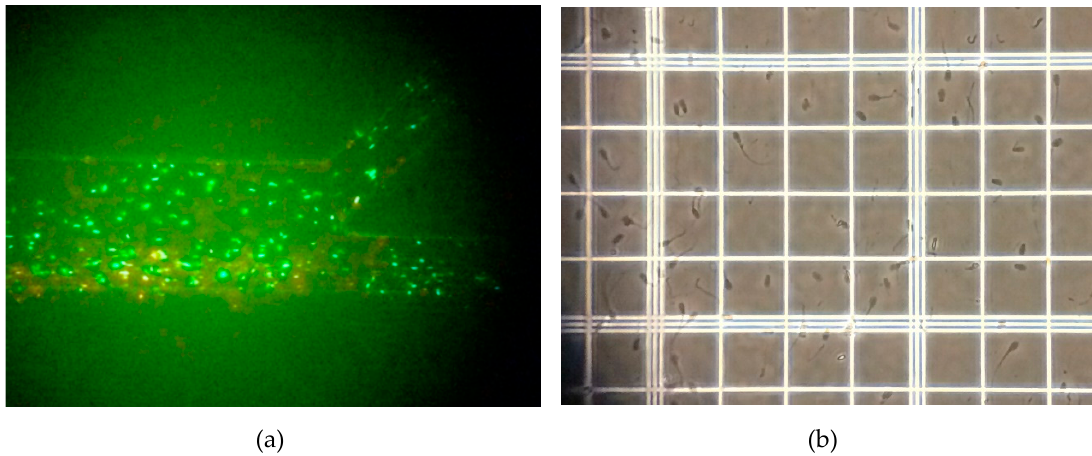
Figure 4. Isolation of motile sperm from immotile sperm and cellular debris in two laminar fluid streams. ( a ) Red and green represent immotile and motile sperm, repectively; and ( b ) determining the concentration of the motile sperm using a hemocytometer.